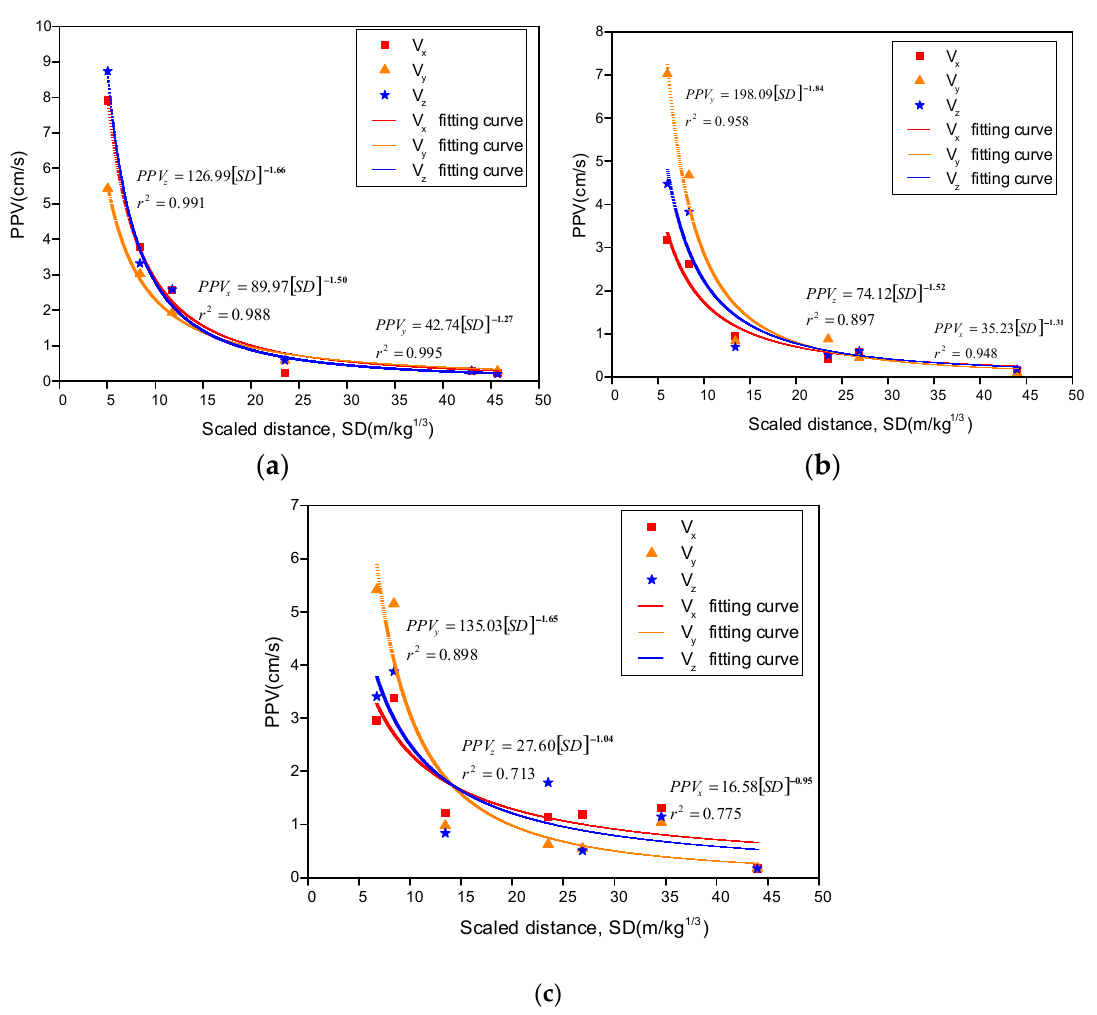
Figure 8. Regression results of PPV and scaled distance in (x) longitudinal, (y) tangential and (z) vertical directions. ( a ) Masonry, ( b ) plain concrete, and ( c ) roller compacted concrete.